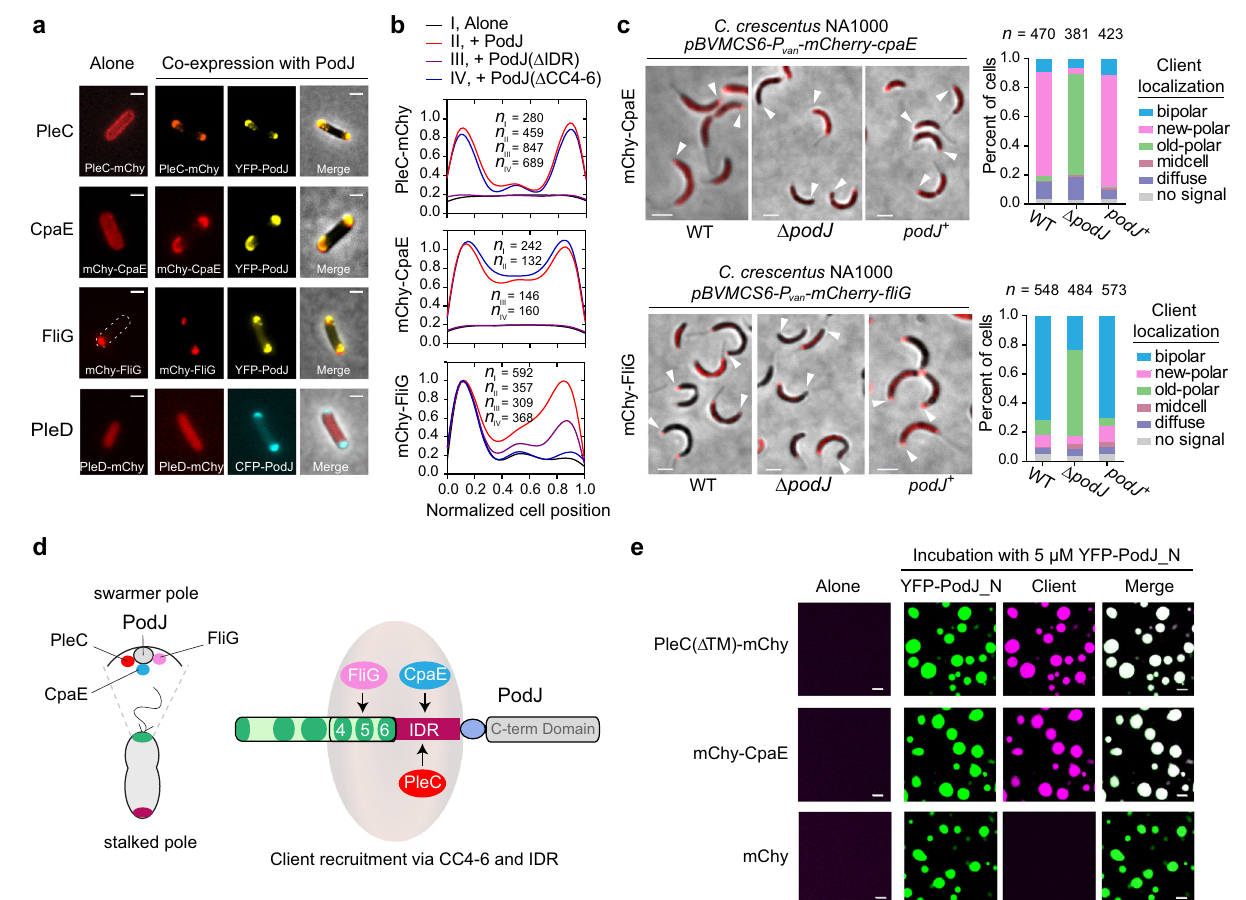
Fig. 4 | PodJ recruits client proteins via the LLPS-related domains. a Identi fi cation of PodJ clients in E. coli . Three out of 23 proteins (PleC, CpaE, and FliG) were identi fi ed by co-expressing them with PodJ to observe their subcellular localization changes in E. coli . PleD is shown as a negative control. b Quantitative analyses of the client signal along the cell lengths. These client proteins were expressed alone or co-expressed with PodJ (or PodJ variants) using the same induction concentration in E. coli . Data were normalized with the highest intensity as100%inproteinlocalizedstrains. c Con fi rmationoftherecruitmentforCpaEand FliGtothe new cellpolesbyPodJin C.crescentus . mCherry-CpaEand mCherry-FliG